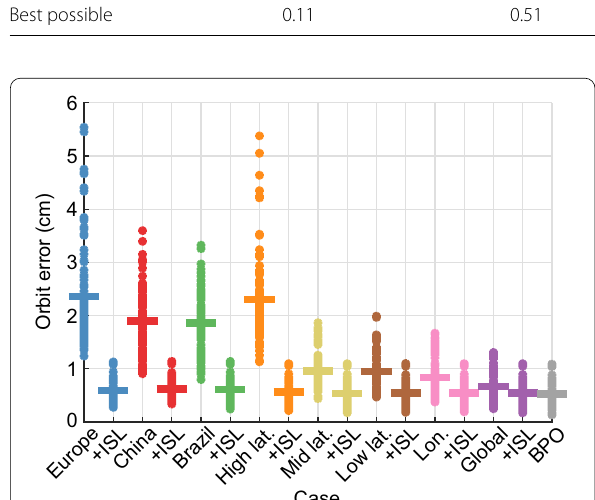
Fig. 3 3D mean RMS of orbit errors for each case. For each case, orbit errors of individual satellite are marked as stars and the mean of all satellites is marked as a bar. “ ISL” means that ISL observations + are included in the estimation together with observations from the station network of the same